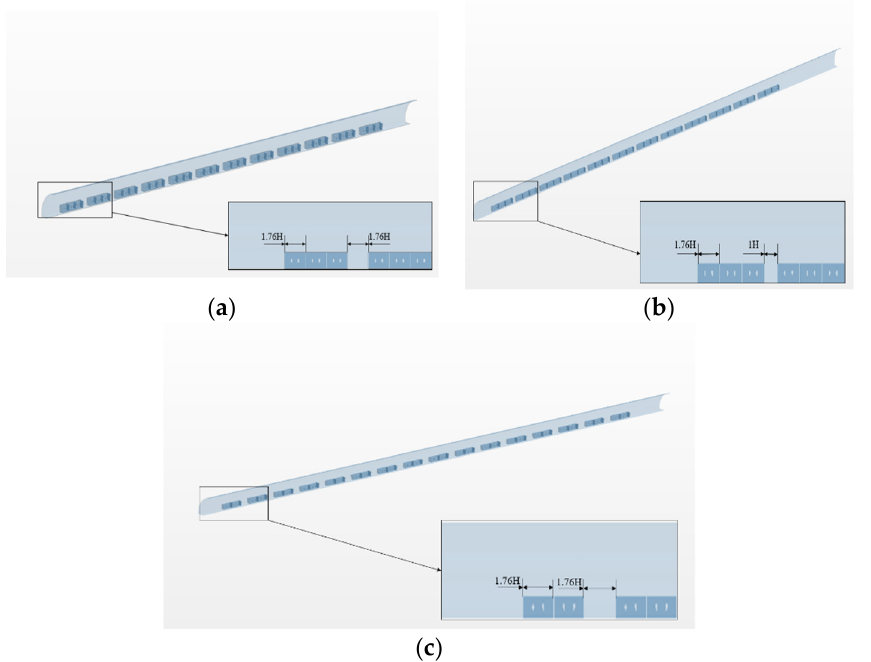
Figure 13. ( a ) 72-cavity new tunnel arrangement 1; ( b ) 72-cavity new tunnel arrangement 2; ( c ) 64- cavity new tunnel arrangement.